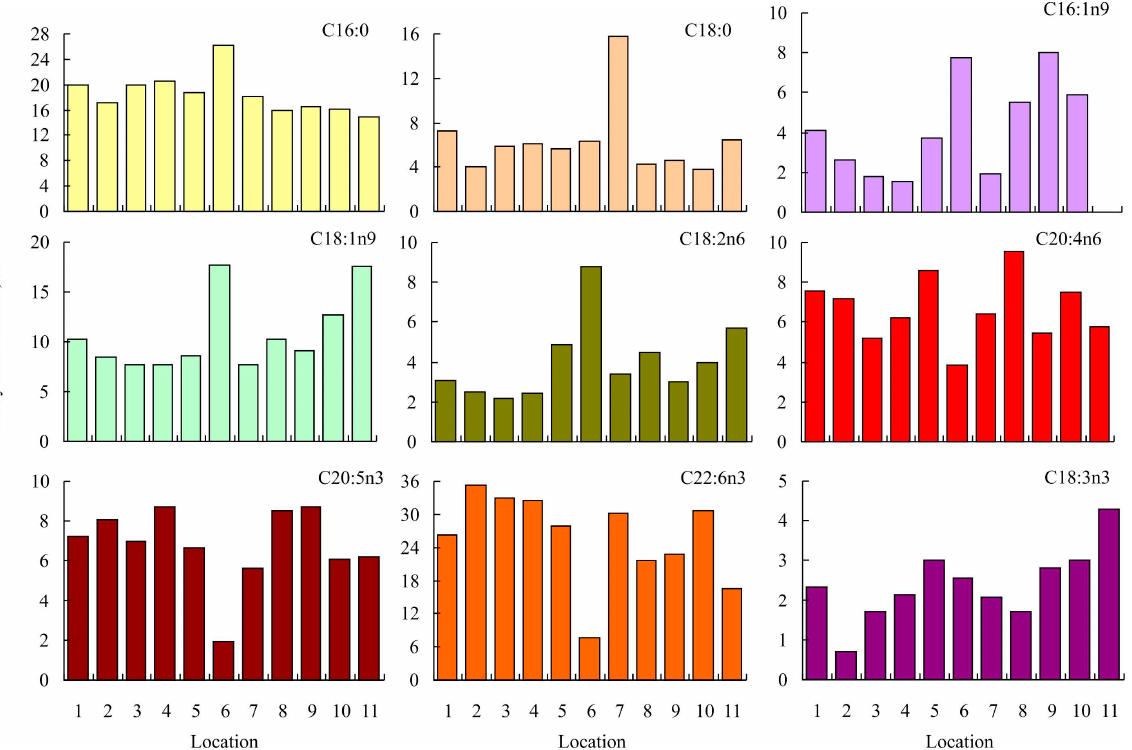
Figure 1. Spatial variations in the proportion of major fatty acids in the flesh of northern pike.